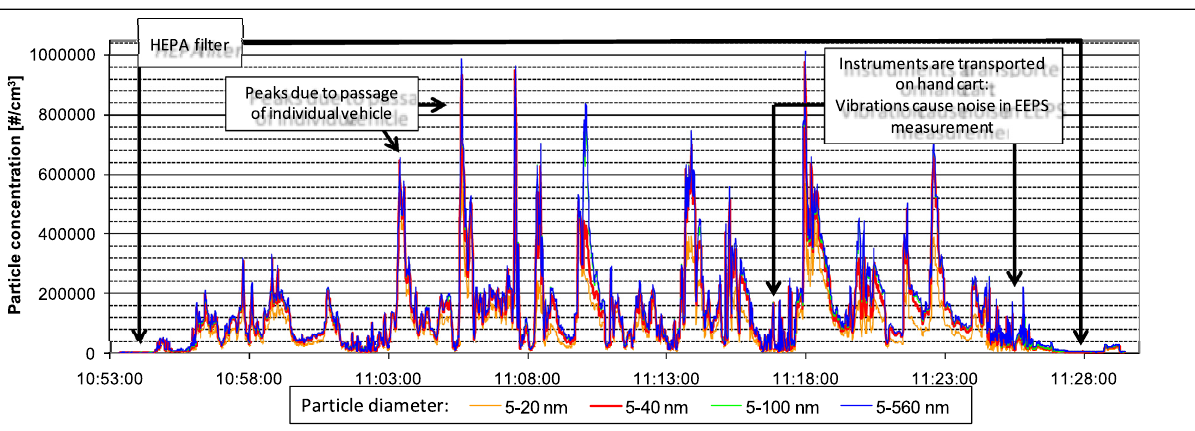
Figure 9. Number particle concentration time course within hotspot measurement in Sporilov on 26 March. Truck acceleration is peculiar for this measurement site.